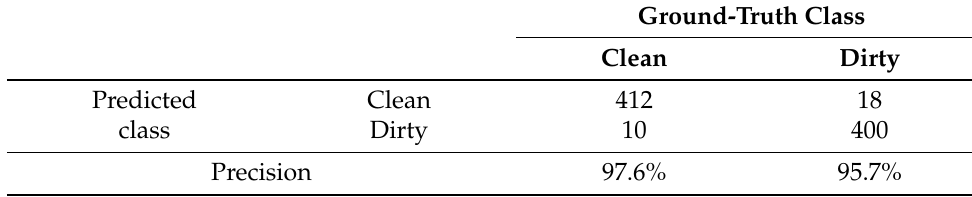
Figure 12. Examples of misclassification. Table 8. Confusion metrics on test